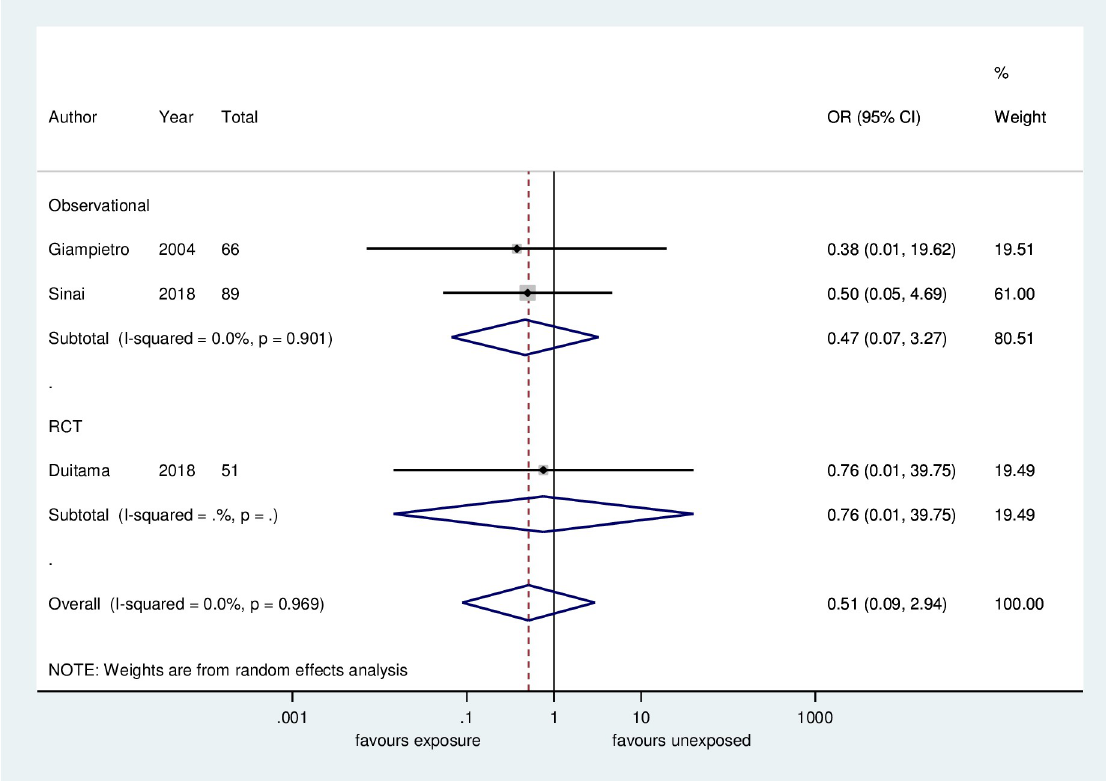
Fig 2. Meta-analysis of the frequency of precocious puberty: Soy-based diet versus non-soy-based diet.